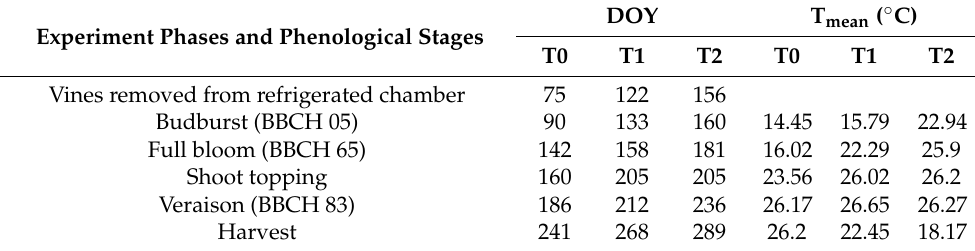
Table 1. Timing (DOY) of experiment phases and key phenological stages for the three treatments and mean temperature (T mean ) during the days between each phase. Experiment Phases and Phenological